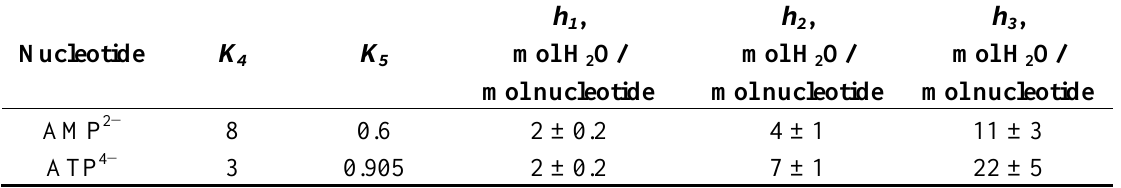
Table 1. Decomposition of the experimental isotherms for AMP and ATP: K parameters of Flory–Huggins model, h plateaus, respectively, h Values of h are expressed in moles of water per mole of nucleotide.